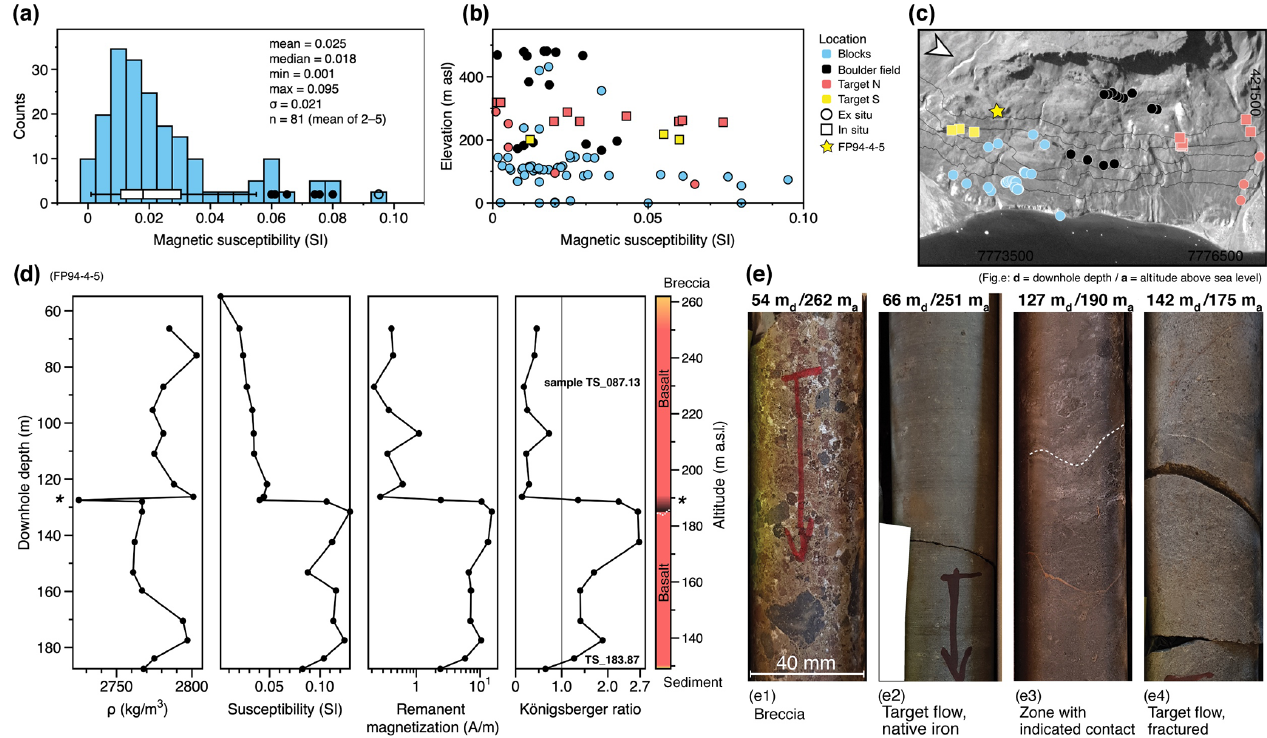
Figure 10. Ground-based susceptibility measurements and petrophysical logs from the drillhole FP94-4-5, based on our measurements. (a) Magnetic susceptibility distribution from handheld measurements. (b) Magnetic susceptibility is plotted against altitude (ma.s.l.) with a location-based colour scheme. The locations are given in map (c) . (d) Petrophysical measurements of density, magnetic susceptibility, remanent magnetization and computed Königsberger ratio for 19 core samples from the drillhole FP94-4-5. Geologic description taken from Olshefsky et al. (1995), altitude inma.s.l. given for comparison. The asterisk marks the contact between the upper and lower part of the magmatic body, having different petrophysical properties. (e) Photographs of four representative core sections ( m d = downhole depth; m a = height in ma.s.l.). We use the reported legacy coordinates but our DEM-based drillhole